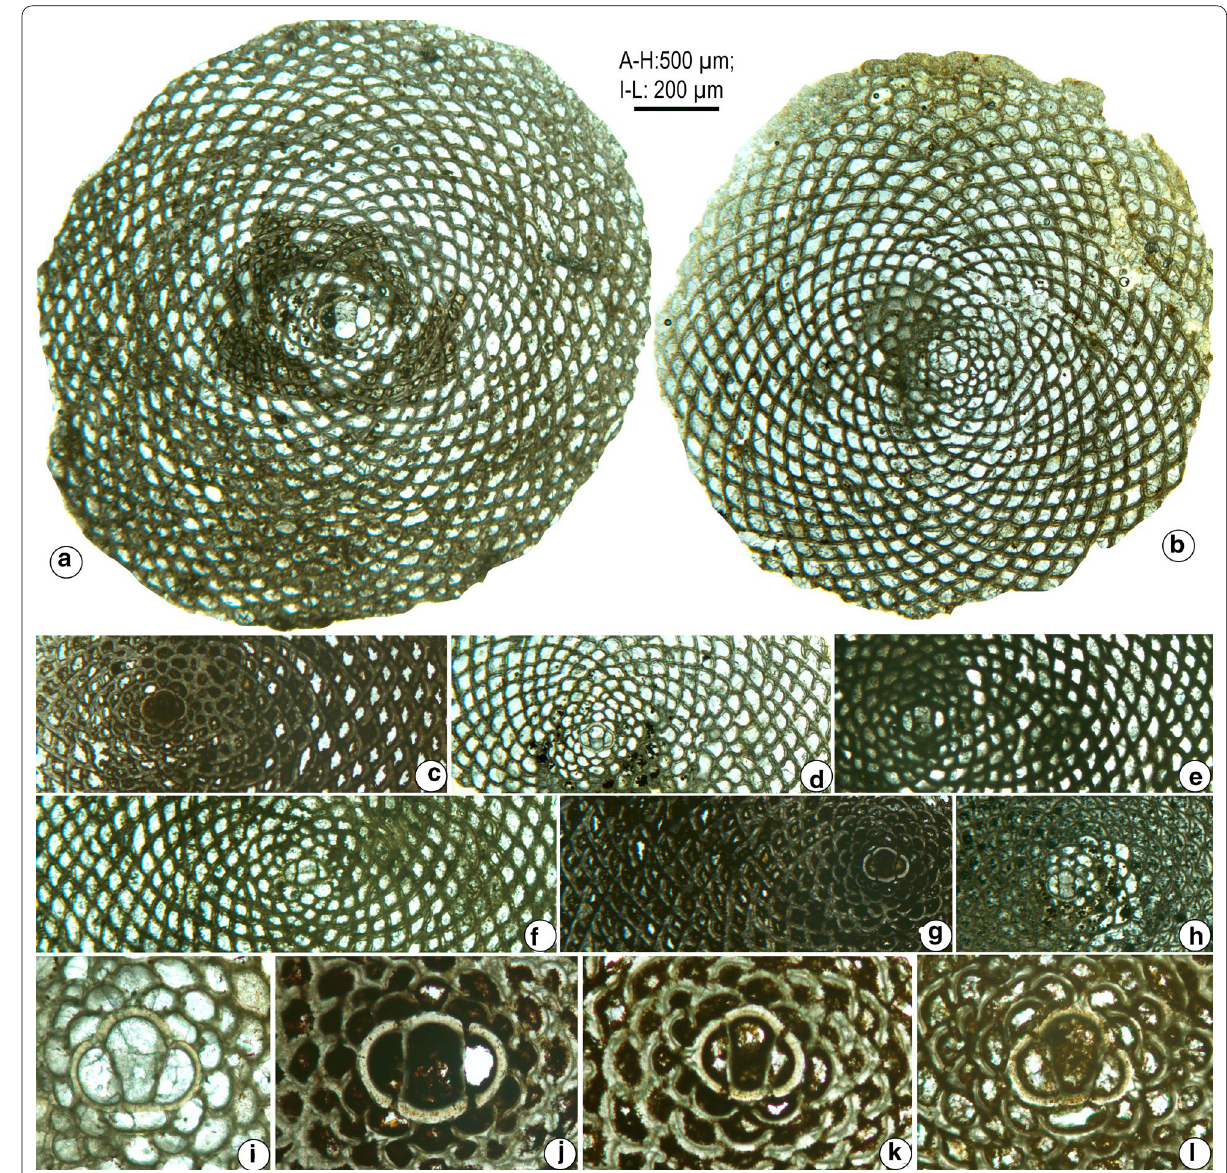
Fig. 17 Equatorial sections of O. pamiri from the Taraklı Formation in Epçeler B section. a EPB5-36. b EPB6-8. c EPB3-1. d EPB6-43, e EPB6-11. f EPB1-7. g EPB3-4. h EPB4-7. i EPB1-5. j EPB3-16. k EPB3-18. l EPB3-28. Note that specimens in i and l have 3 epi-embryonic